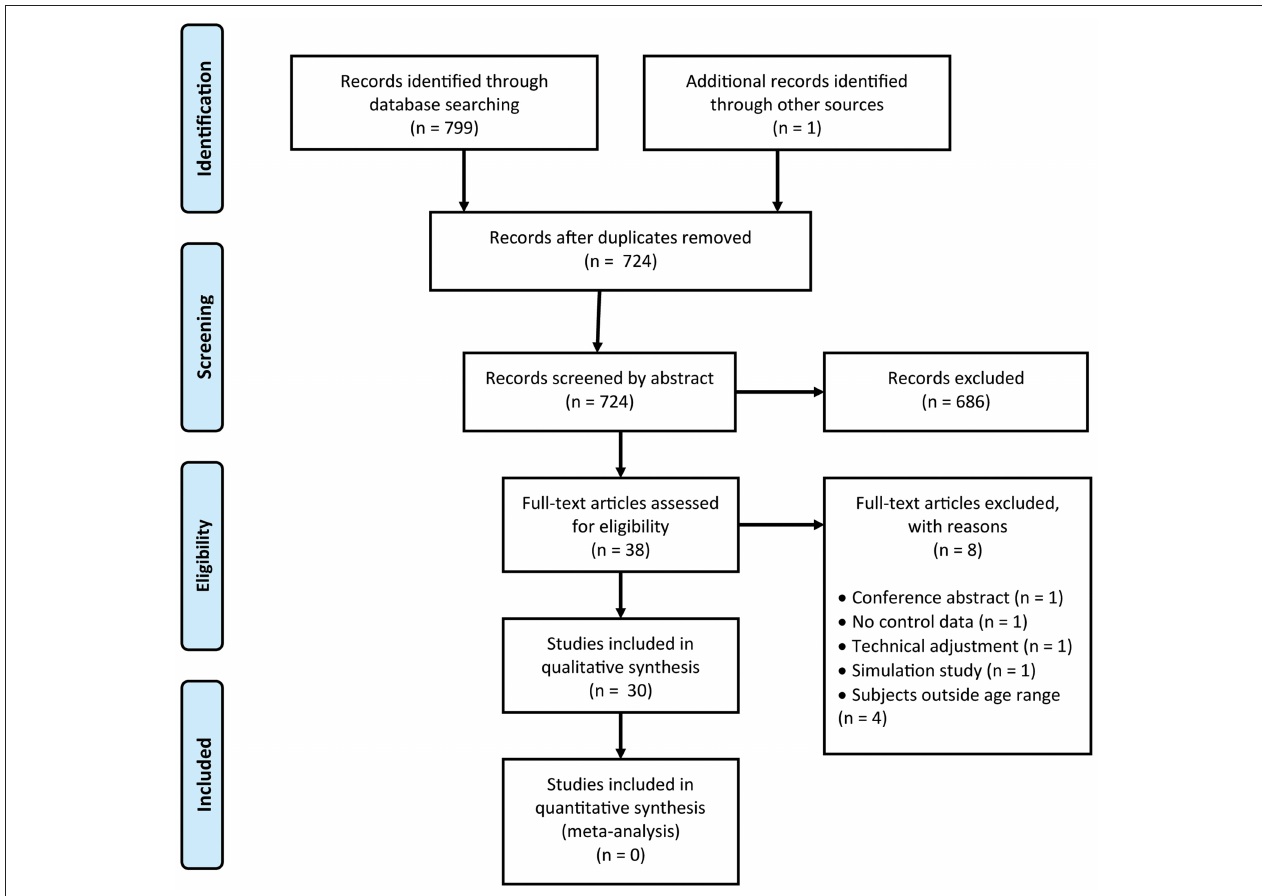
FIGURE 1 | PRISMA 2009 Flow Chart.